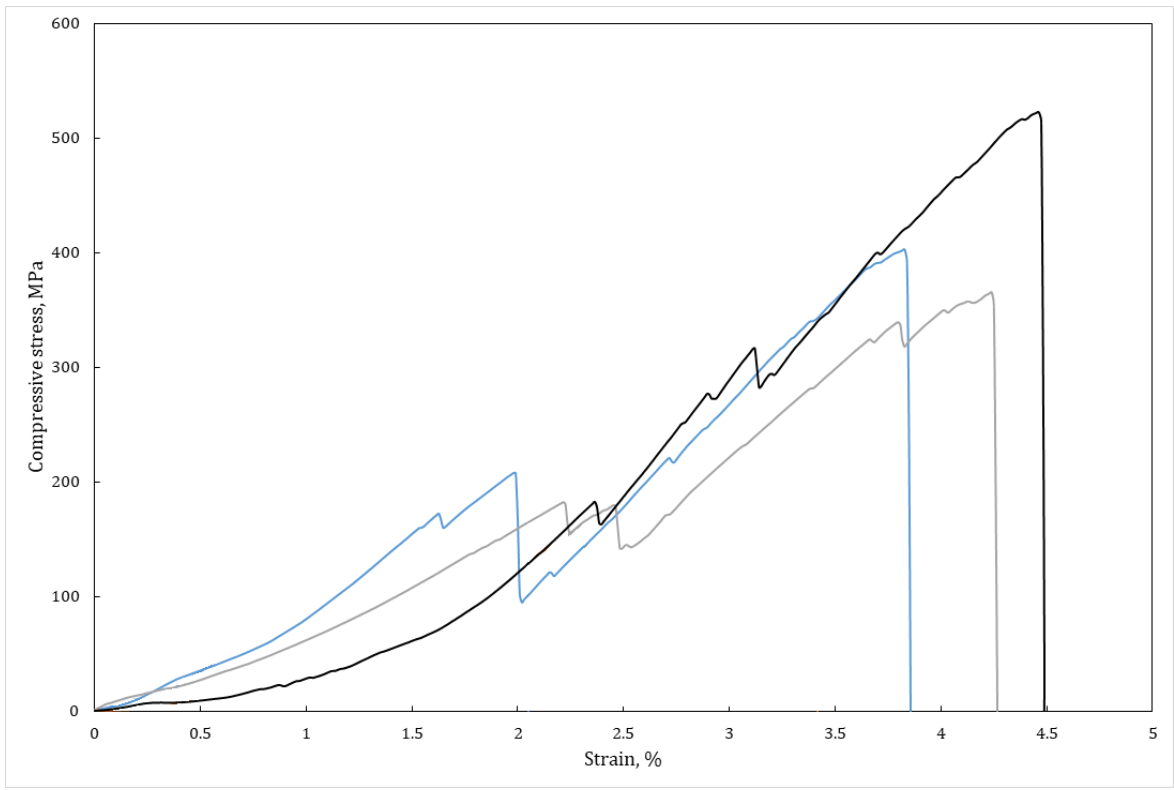
Figure 8. Stress-strain diagram for three reactively pressed TiB 2 -BN-C samples. Table 2. Some mechanical properties of different soft ceramics for high-temperature applications. Composition,